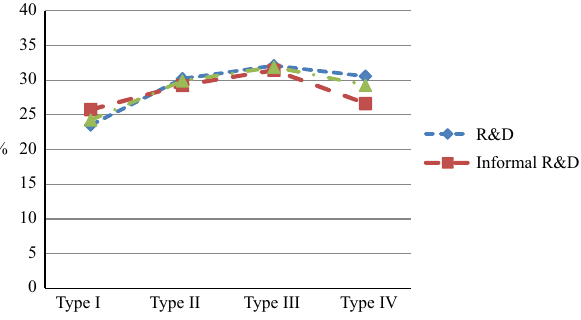
Figure 1. Product innovation: